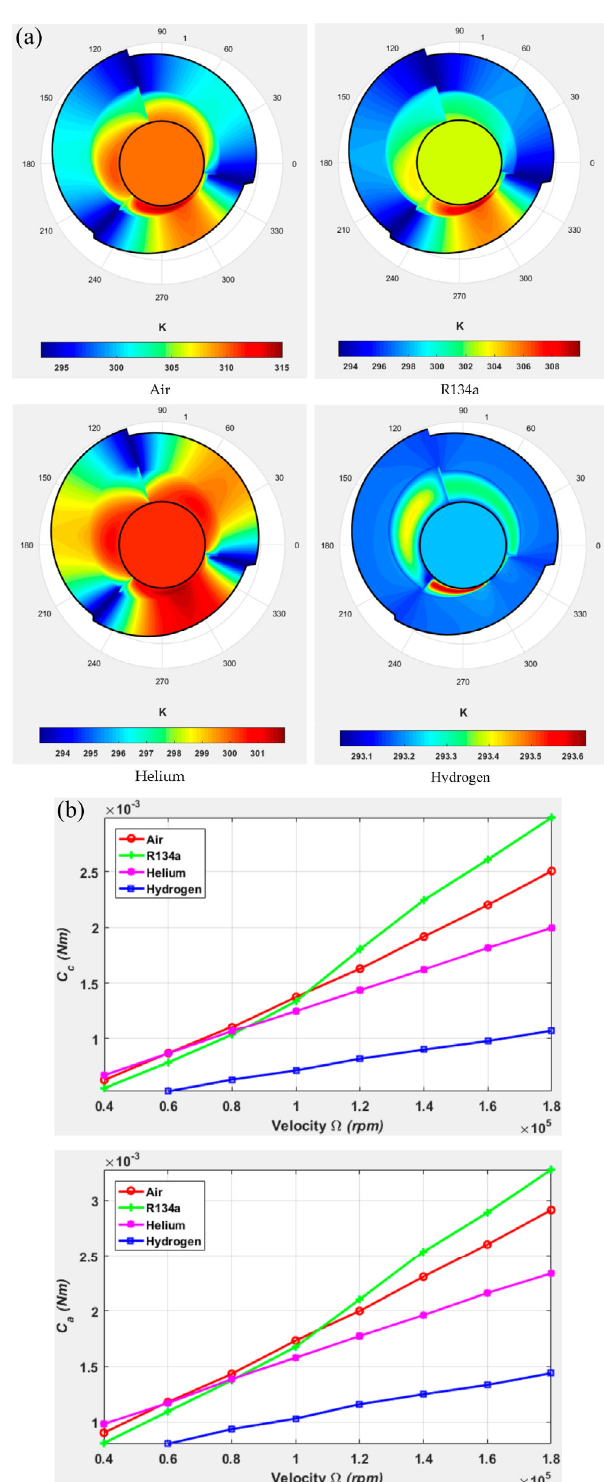
Fig. 15 (a) Temperature distribution in the solids (shaft and housing). (b) Housing frictional torque Cc and (c) shaft frictional torque Ca versus shaft speed, bearing load 10 N, preload m = 0.2 [208]. Reproduced with permission from Ref. [208], © The authors,